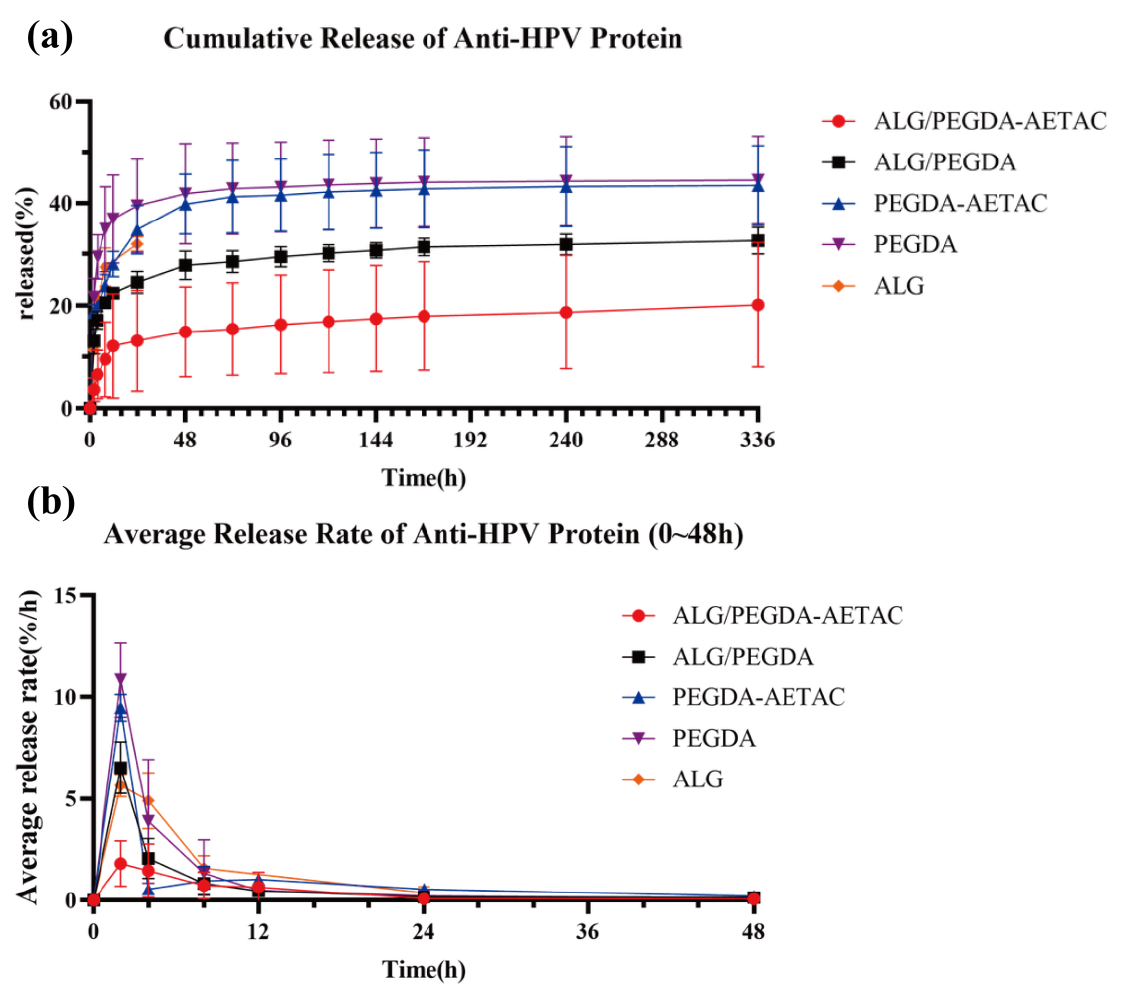
Figure 4. ( a ) Cumulative release of anti-HPV protein. ( b ) Average release rate of anti-HPV protein.